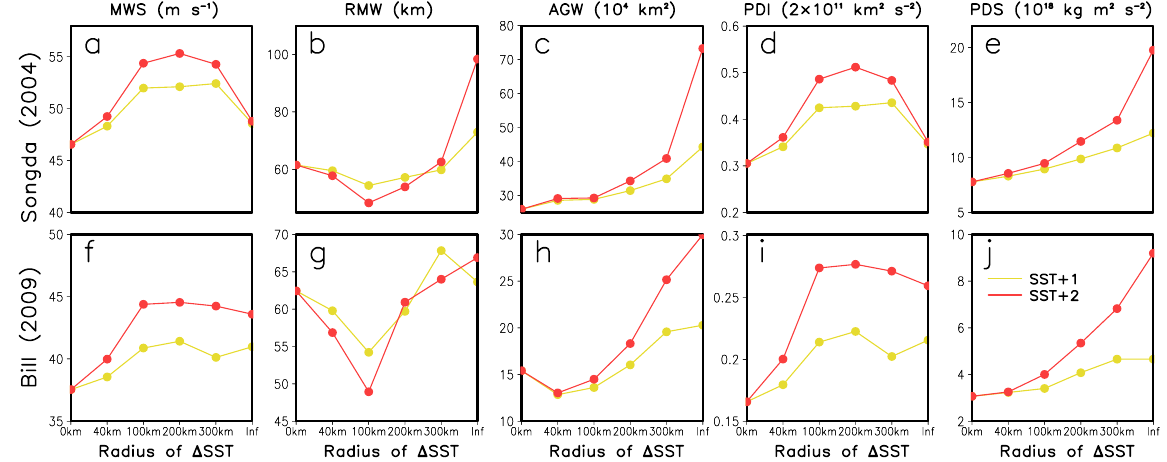
Figure 2. Changes in time-averaged MWS, RMW, AGW, PDI and PDS with the radial extent of the warm SST pool in the sensitivity experiments. ( a–e ) Songda (2004); ( f–j ) Bill